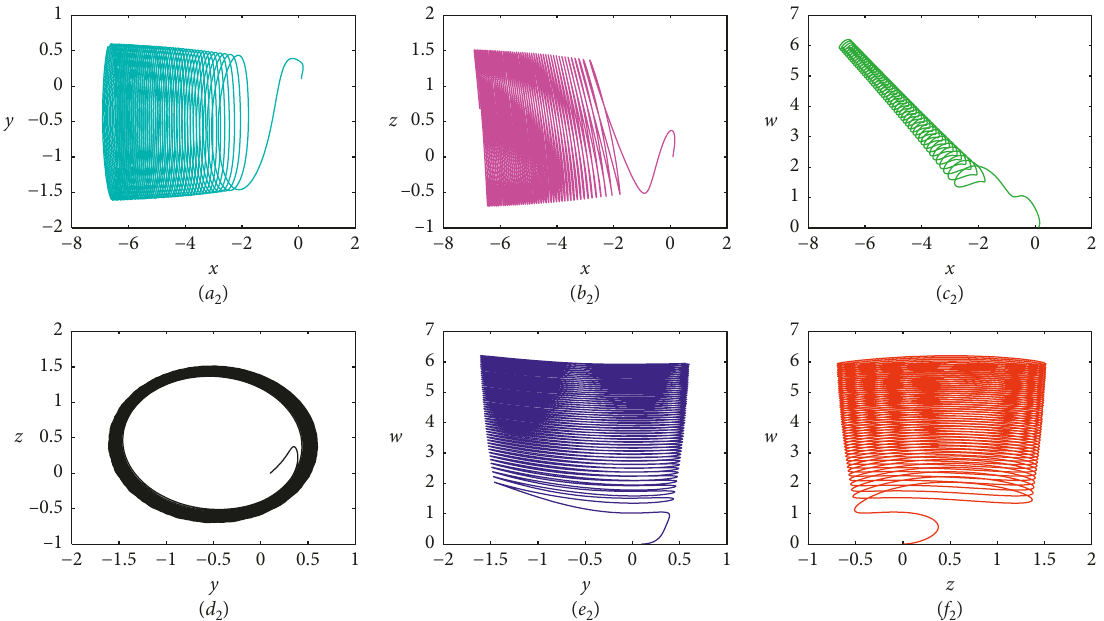
Figure 13: Phase portraits of Experiment 2 with a � 0 . 01 , t � 80: ( a ) on y − w plane; ( f plane; ( e 2